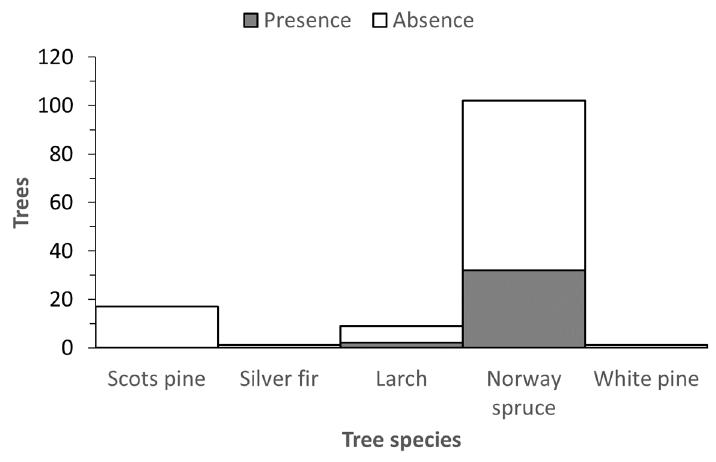
Figure 6. Incidence of carpenter ant nests with respect to tree species in the Czech Republic.